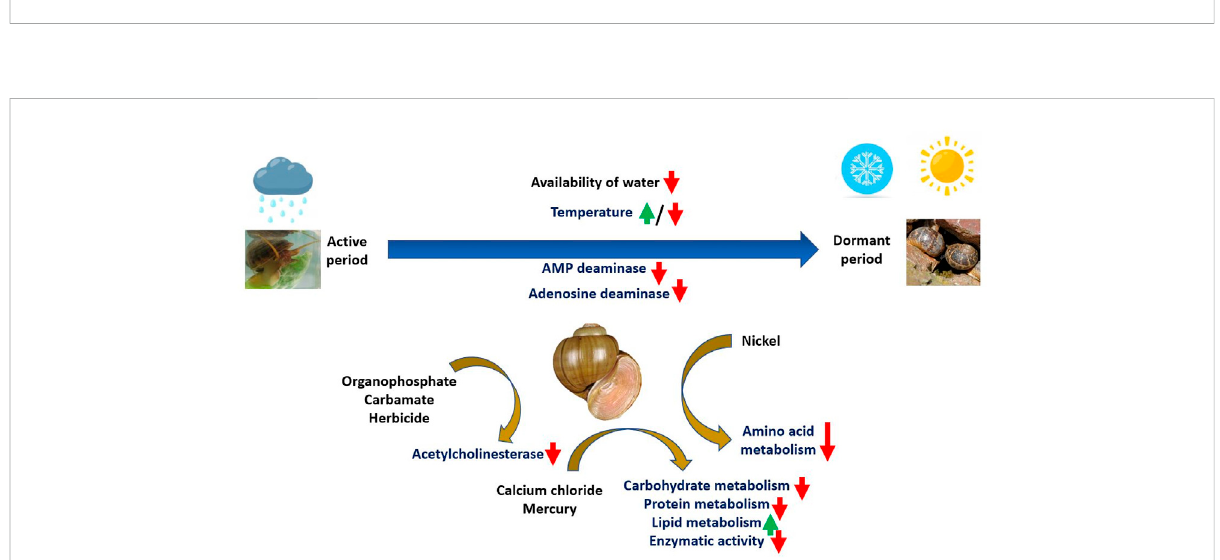
FIGURE 8 Biochemical, physiologic and environmental responses of the snail P. globosa in a grassland ecosystem. Various environmental stimuli in the grasslandecosystemareresponsibleforinducingbiochemicalandmolecularresponsesinthesnailduringtheactiveandinactivephasesoflifecycle. The responses start with ammino-acid catabolism to several enzymatic responses, as shown in the fi